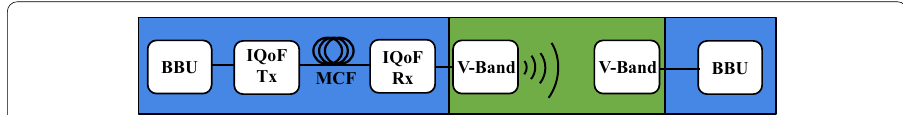
Fig. 3 Proposed schematic for the mmWave point‑to‑point link for the joint demonstration of blueSPACE and